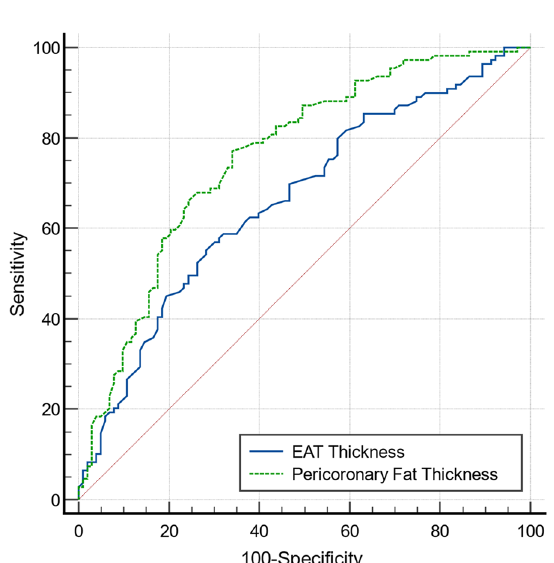
Table 2 Correlation between epicardial fat and severity of CAD Epicardial fat on CT angio